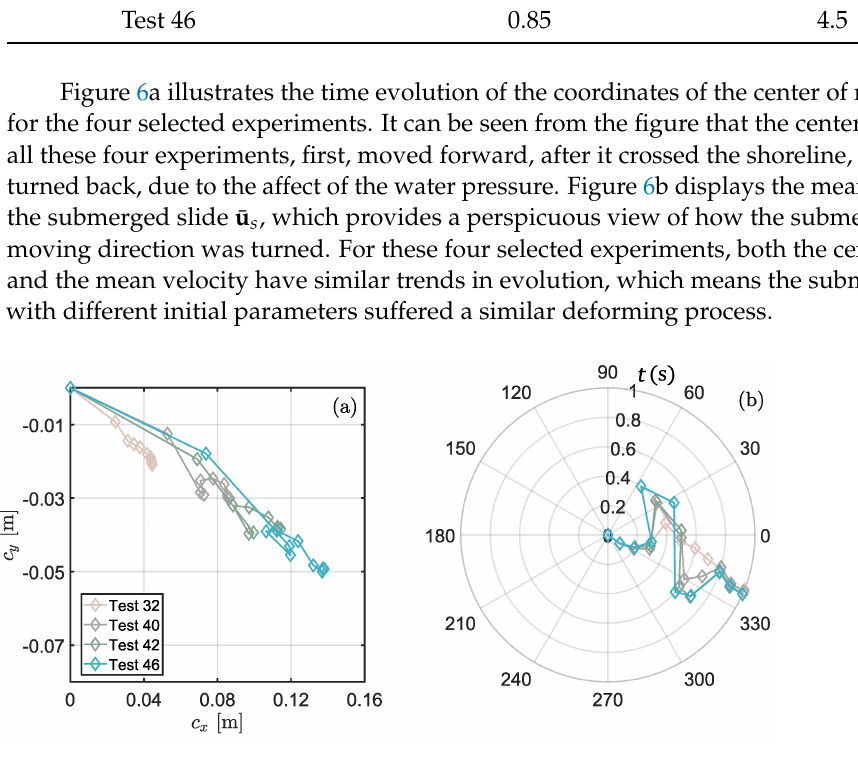
Figure 6. Time evolution of the ( a ) center of mass ( c x , c y ) and ( b ) mean velocity of the submerged slide ¯ u s . The time span δ t between each rhombus was 0.1